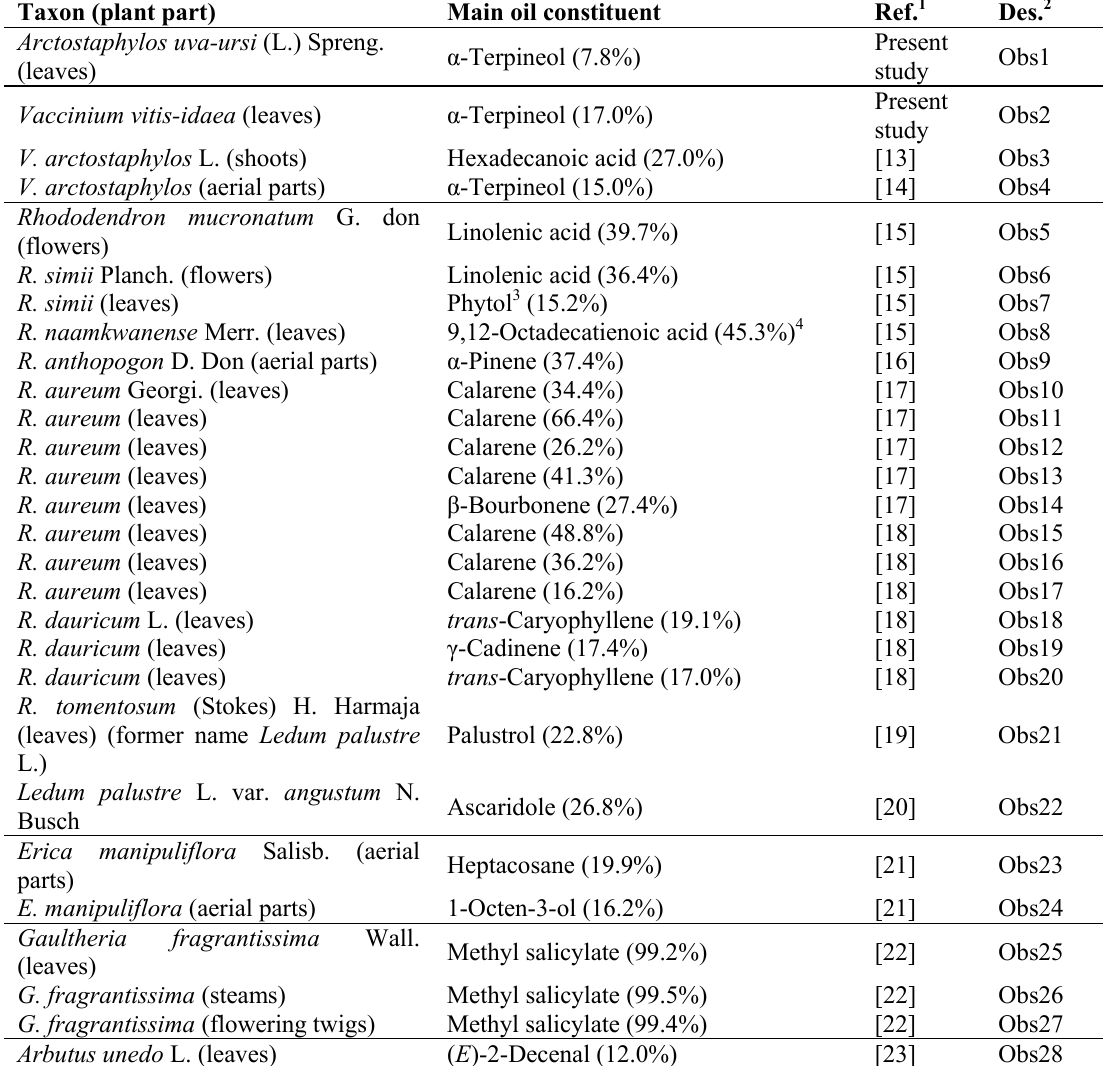
Table 2. List of essential oil samples used in statistical